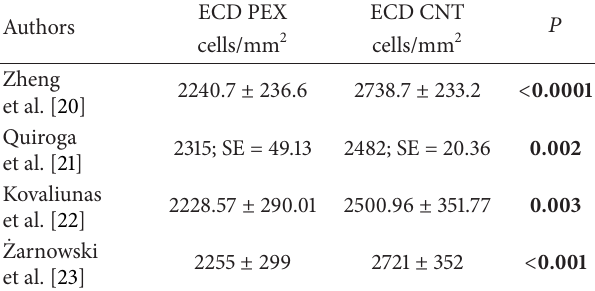
Table 4: Result summary of research comparing cell density of the corneal endothelium (ECD) of patients with PEX syndrome to the ECD of people without PEX